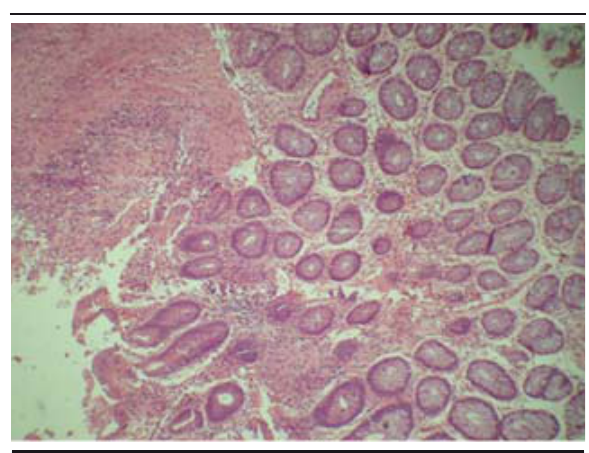
Figure 3. Section of the lesion showing inflamed colonic mucosa and adjacent ulcer base consisting of inflammatory granulation tissue and underlying muscularis.